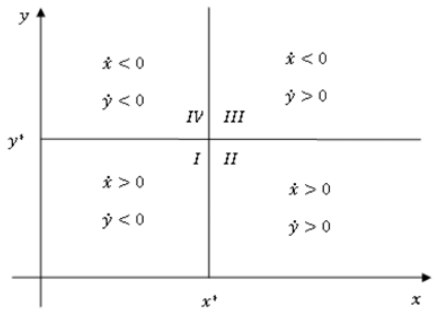
Figure 1. Phase portraits for Lotka Volterra system (2).